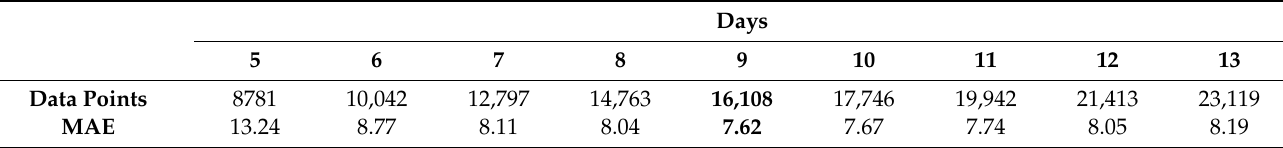
Table 5. Minimum MAE corresponding to different days of data set